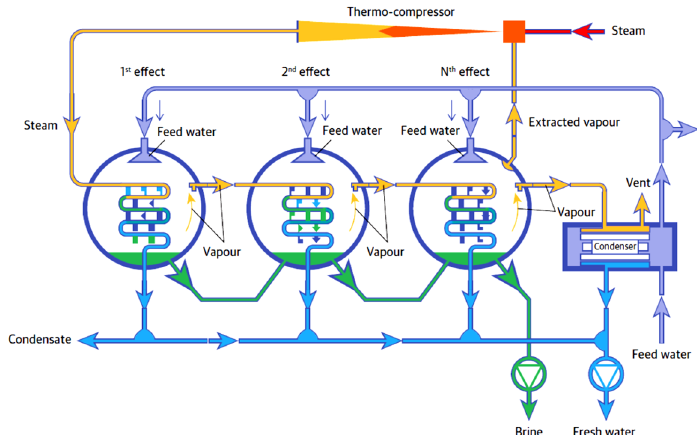
Figure 4. Schematic of MED technology [15]. [Copyright ©, 2006, Veolia Water Technologies].